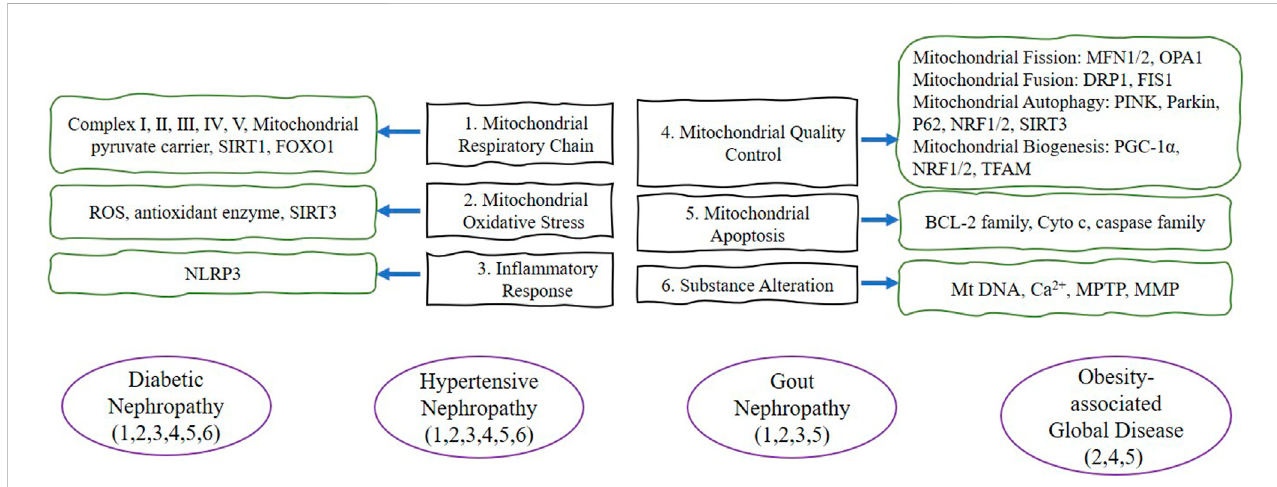
FIGURE 2 The purple lines represent the four disease types in this review. The green lines brie fl y depict the target proteins corresponding to the mitochondrial dysfunction in this review. The black frame describes the six mitochondrial dysfunctions summarized in this review. Abbreviation: SIRT1 (Silent information regulator 1), FOXO1 (forkhead transcription factor-O1), ROS (reactive oxygen species), SIRT3 (Silent information regulator 3), NLRP3 (NOD-like receptor protein 3), MFN1/2 (Mitofusin 1/2), OPA1 (Optic atrophy 1), DRP1 (dynamin-related protein 1), FIS1 (Fission 1), PINK (PTEN induced putative kinase 1), P62 (SQSTM1, sequestosome 1), NRF1/2 (nuclear response factor 1/2), PGC-1 α (Peroxisome proliferator-activated receptor-gamma coactivator-1alpha), TFAM (transcription factor a mitochondrial), BCL-2 (anti-apoptotic protein B-cell lymphoma-2), Cyto c (cytochrome c), MtDNA (mitochondrial DNA), MPTP (Mitochondrial permeability transition pore), MMP (mitochondrial membrane